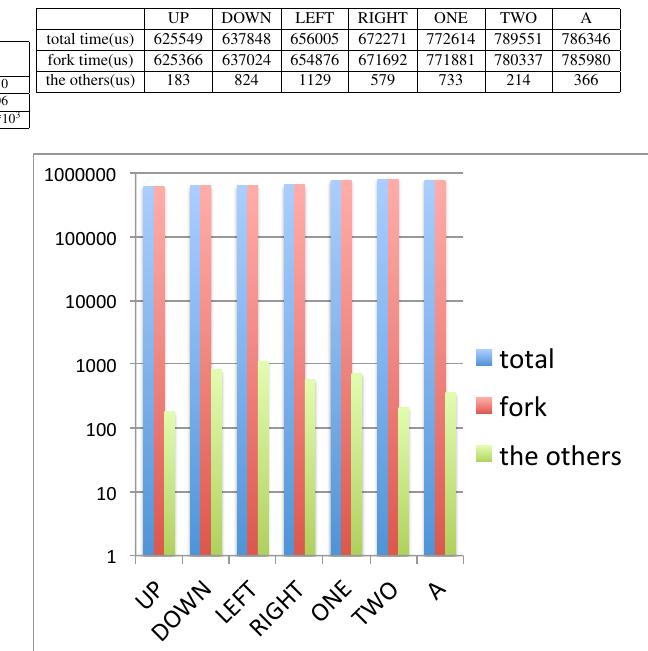
Table 2. each button input time